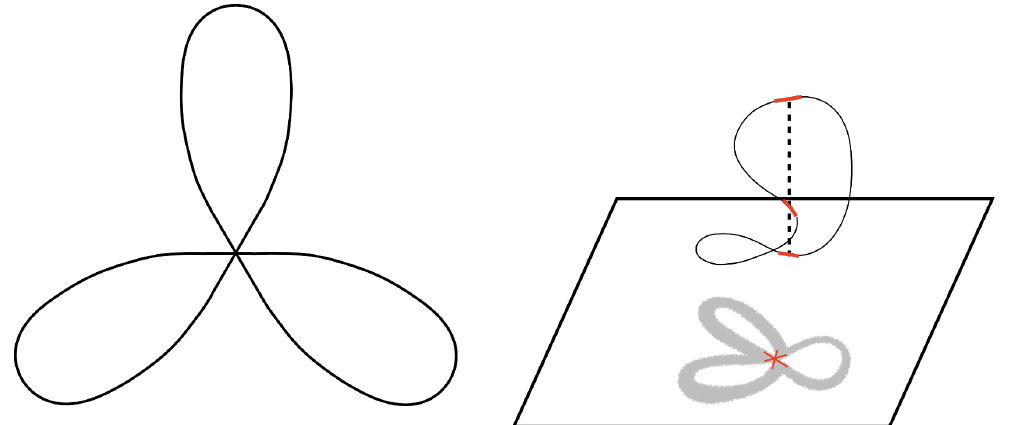
Figure 2 . A star-crossing singularity with k = 3 locally intersecting components.